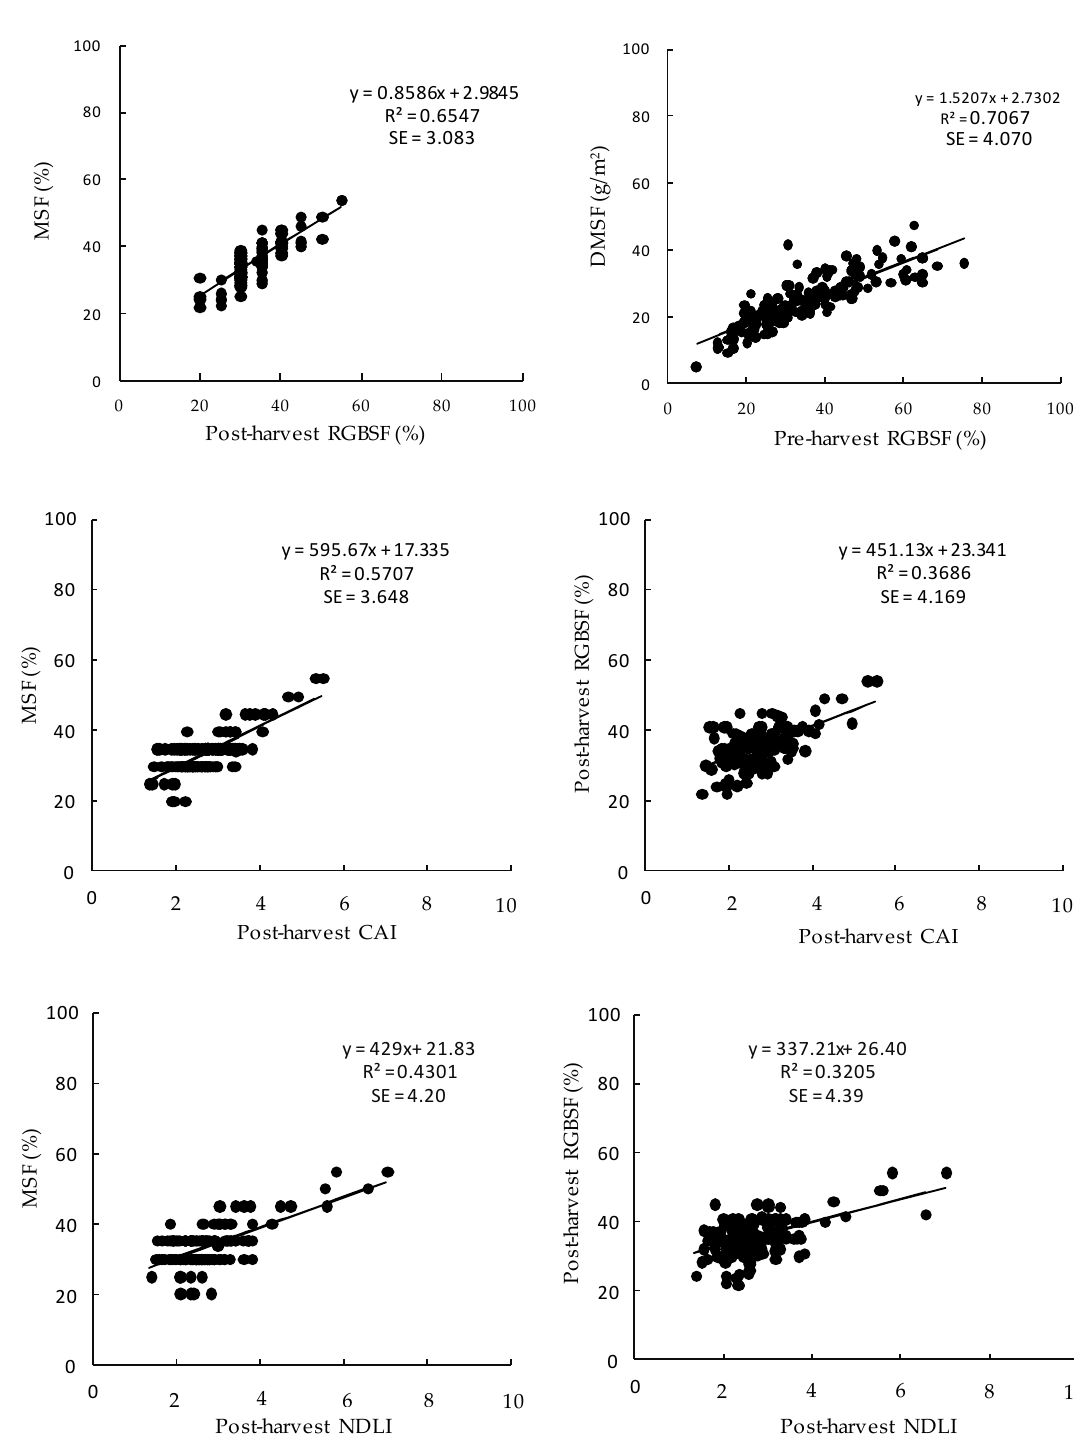
Figure 9. Linear regression for the plot-level perennial ryegrass dead fraction prediction, n = 162, where MSF is the manual senescent fraction, DMSF is the dry matter of the senescent fraction, RGBSF is the RGB image-based senescent fraction, CAI is the cellulose absorption index, and NDLI is the normalized difference lignin index.